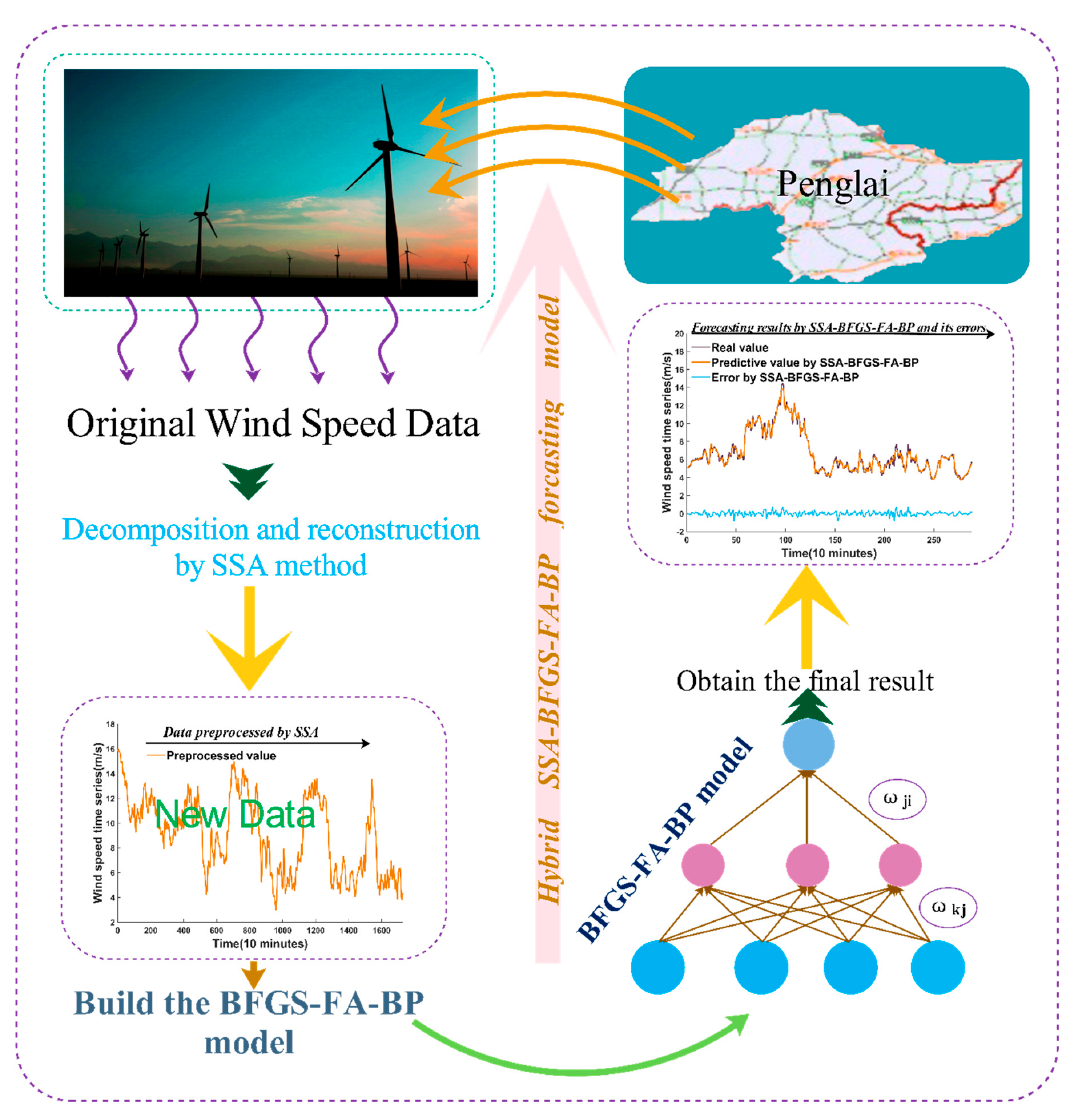
Figure 2. The flow chart of the hybrid SSA-BFGS-FA-BP model.